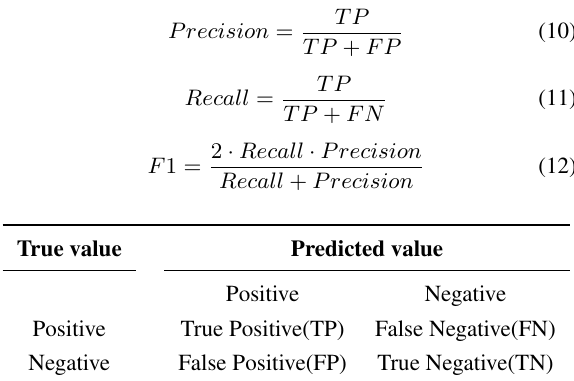
Table 1. Combined relationship between true labels and predicted results.